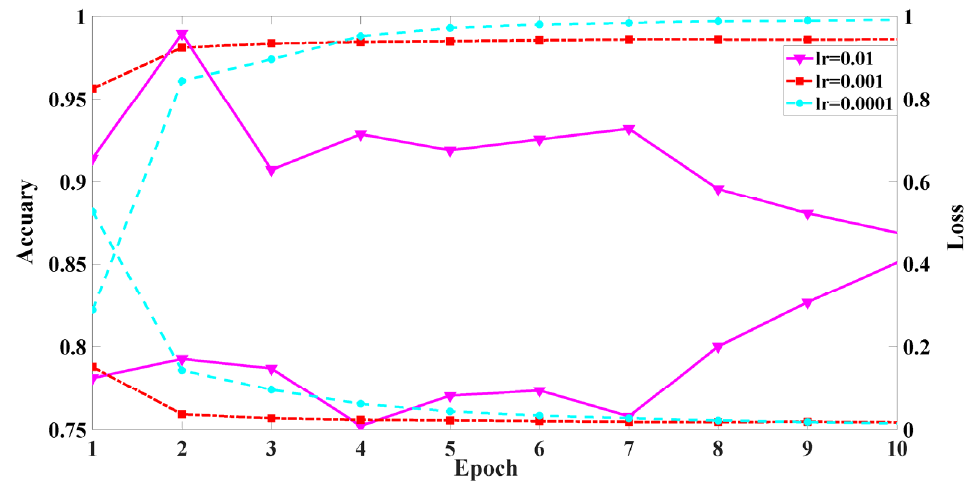
Figure 9. The model performance of different learning rates.